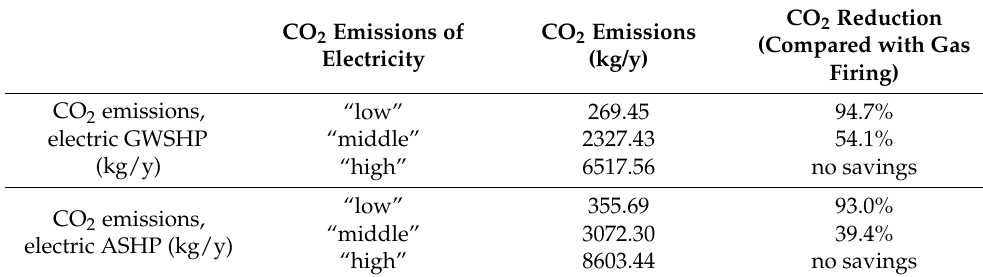
Table 3. CO 2 emissions of the studied heat pump systems in kg/y in the case of a theoretical house with a heat demand of 90.00